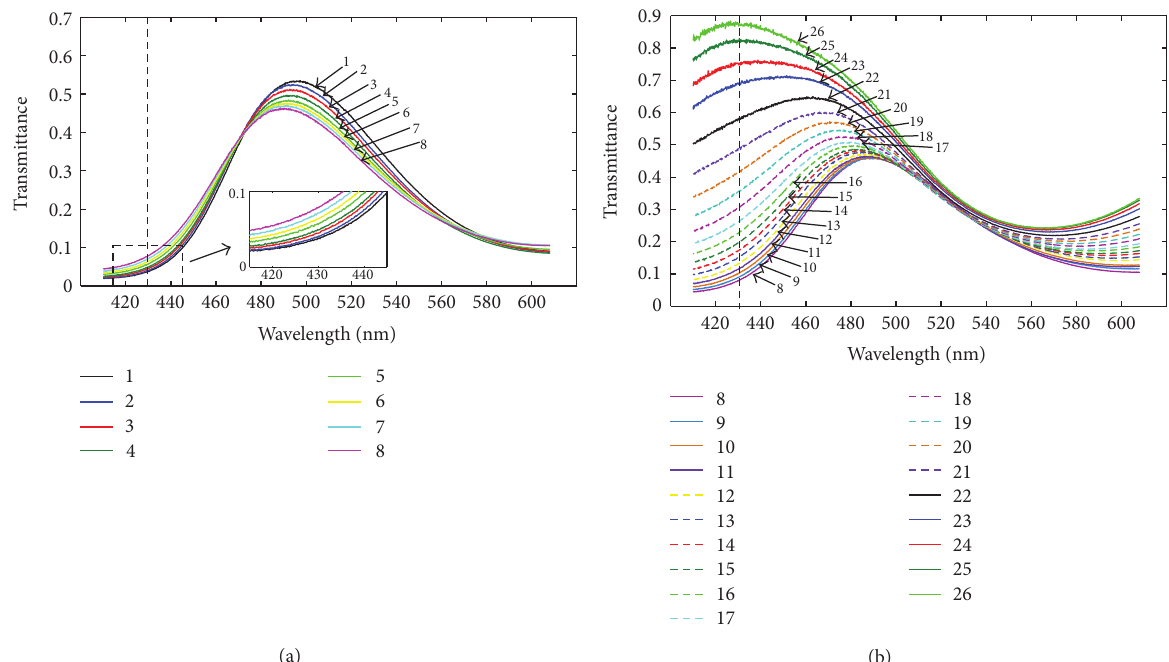
F 5: e normalized transmittance spectra of the 26 measurements for the negative electrolyte in Figure 2(b). e marked area in (a) is enlarged and shown in the bottom of (a).